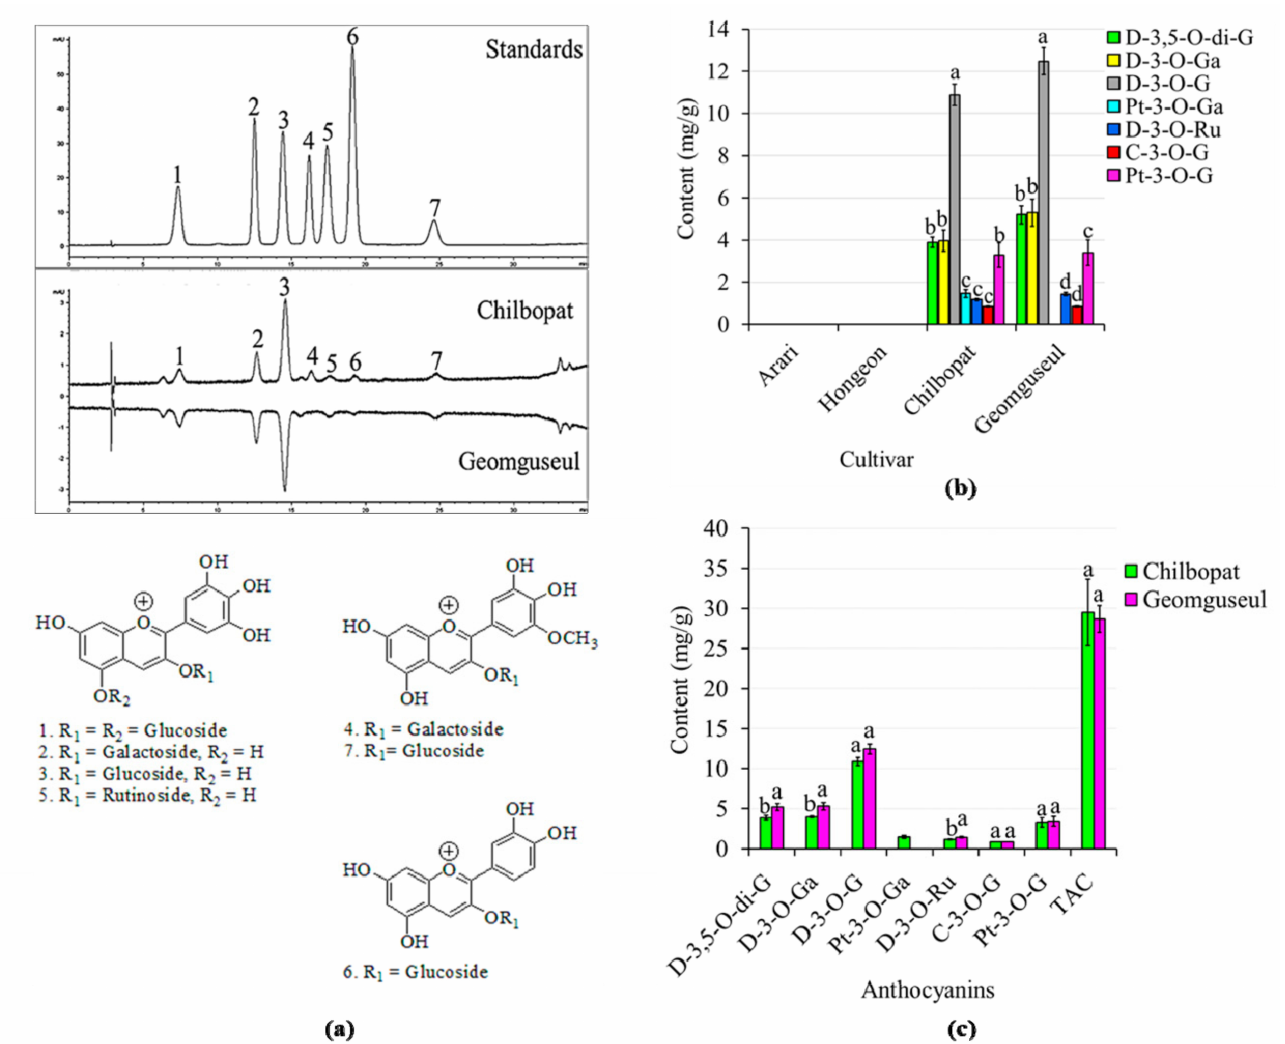
Figure 2. HPLC-chromatograms of standard anthocyanins, adzuki bean seed coat extracts, and struc- tures of target anthocyanins ( a ); variation of anthocyanin contents within ( b ) and between ( c ) adzuki bean cultivars. Peak assignment and retention time (min): 1: D − 3,5 − O − di − G (7.34 min); 2: D − 3 − O